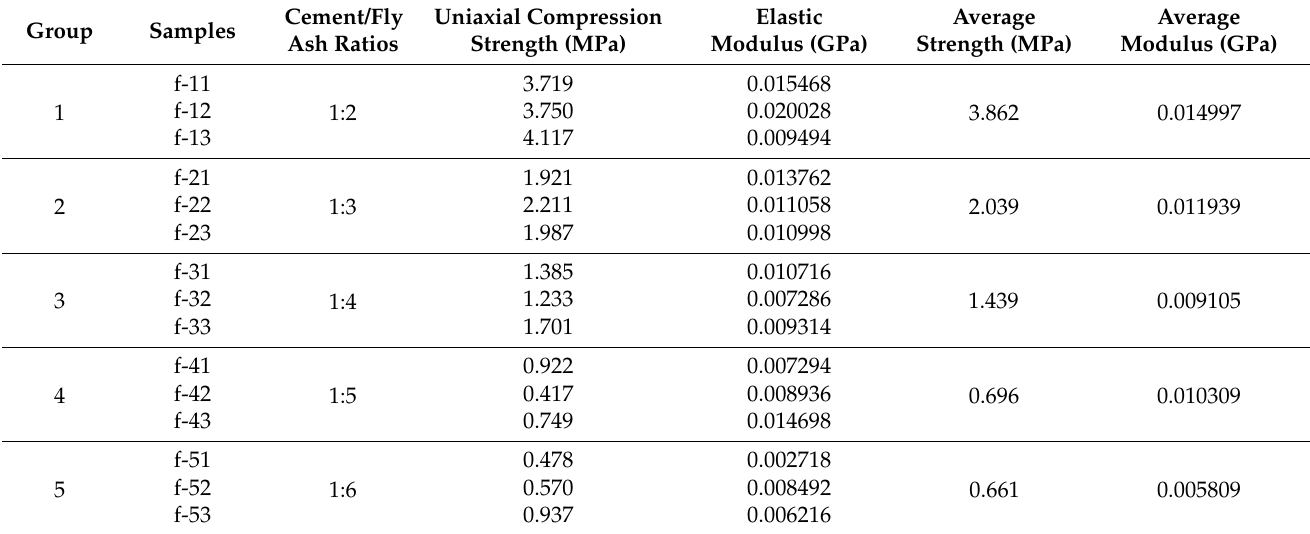
Table 7. Strength and deformation characteristics of backfilling body samples with different Ce- ment/fly ash ratios.